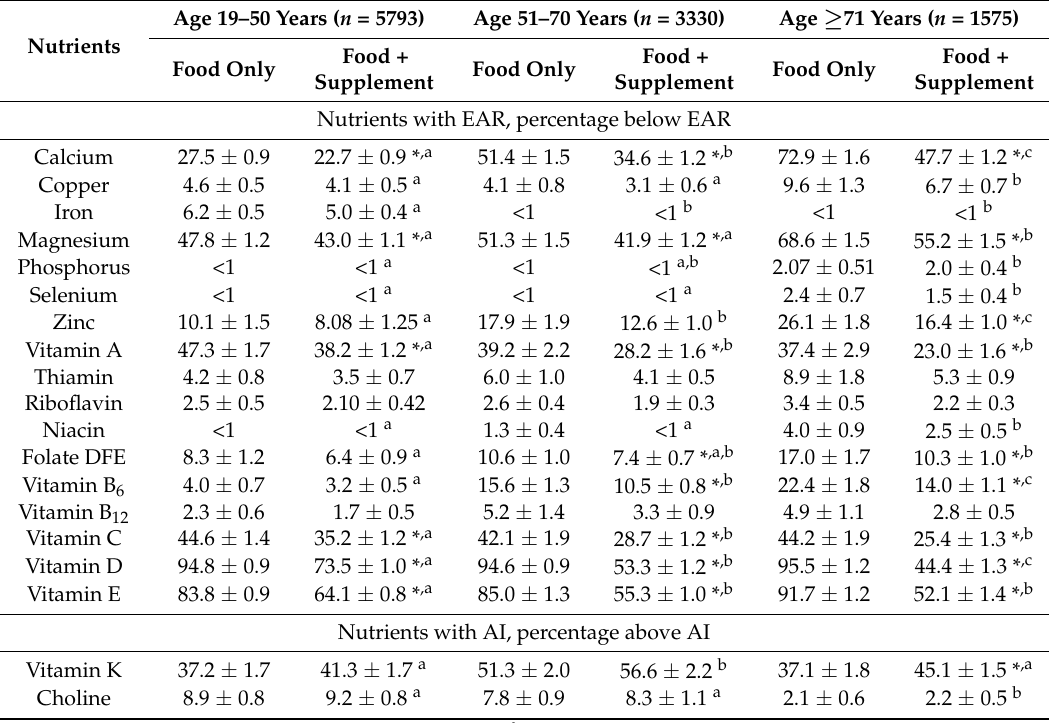
Table 4. Percent of adult (19+ years old) population below Estimated Average Requirement (EAR) or above Adequate Intake (AI) of nutrients from foods and foods + dietary supplements by age